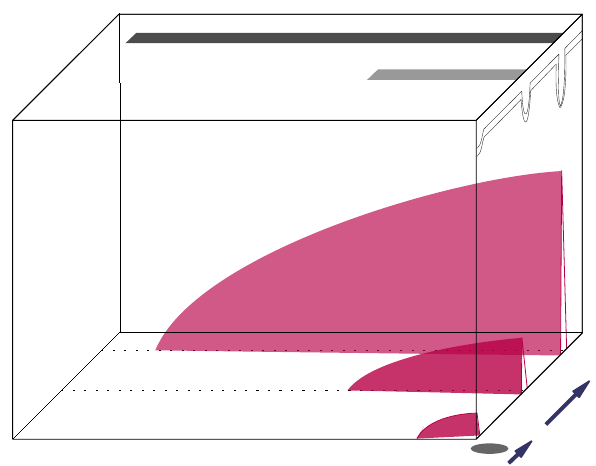
Fig. 7. Sketch illustrating the origin of the surface and internal structure north-west of the ice rumple shown Fig.